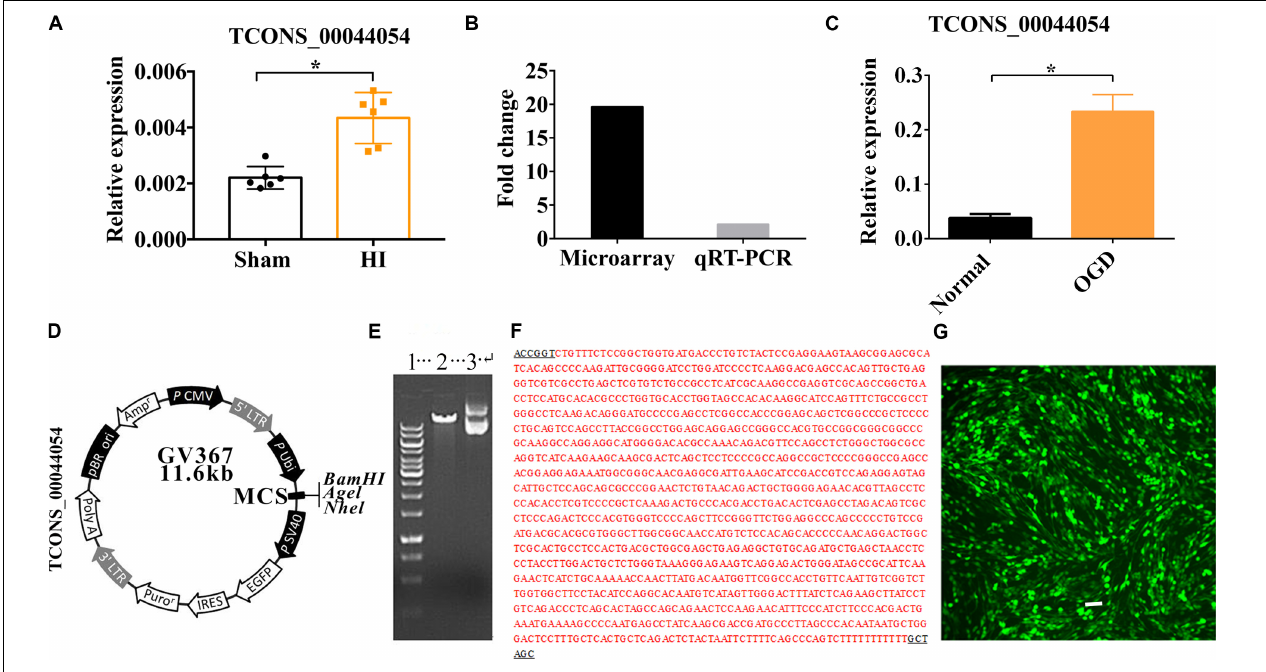
FIGURE 1 | The relative expression of TCONS00044054 (Vi4) in HIE. (A) Quantitative histogram for Vi4 expression in sham and HI groups, n = 6/group (B) The fold change of Vi4 in the microarray and qRT-PCR analysis. (C) Quantitative histogram for Vi4 expression in sham and HI groups. (D,E) The name of vector was GV367 with Age I/ Nhe I enzymes digestion, showing the plasmid molecular weight of the digested products. 1 was for marker (from up to down: 10 kb, 8 kb, 6 kb, 5 kb, 4 kb, 3.5 kb, 3 kb, 2.5 kb, 2 kb, 1.5 kb, 1 kb, 750 bp, 500 bp, and 250 bp), 2 was for digested vector (11.6 kb), and 3 was for non-digested vector. (F) The results of positive clonal sequencing, indicating the clone is ok. (G) The transfection of Vi4-ORF into the PC12 cell line, the green color emerged by GFP represents the successful transfection. Scale bar = 100 µ m. The relative expression was relative to that of the sham or normal group HI group: hypoxic ischemic group. All data are presented as mean ± SD, * P <